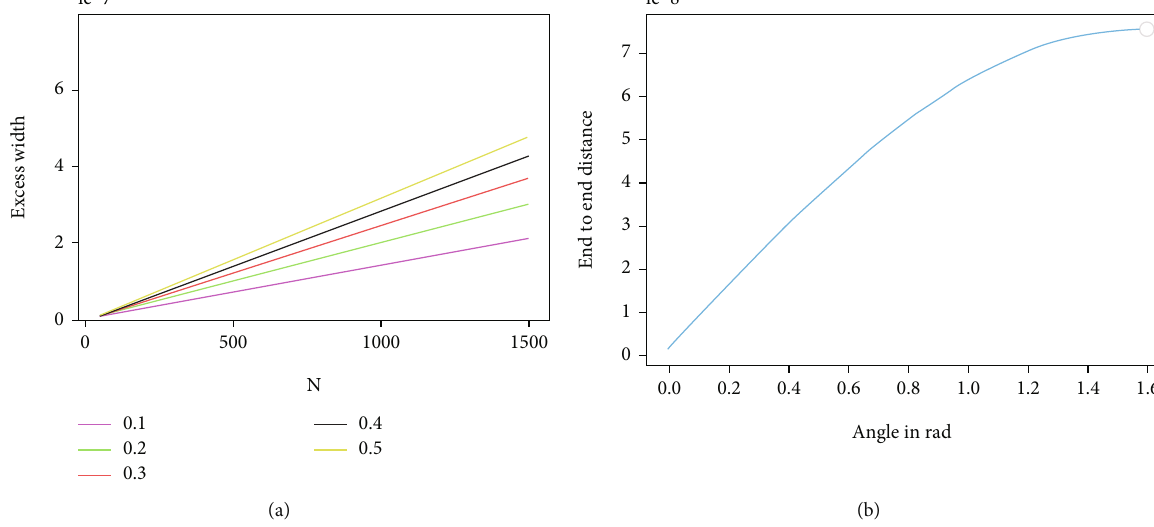
Figure 9: (a) is a plot of the excess width of a polymer brush structure versus the degree of polymerization for di ff erent densities; (b) plot of the horizontal component of a polymer chain in the polymer structure, Equation